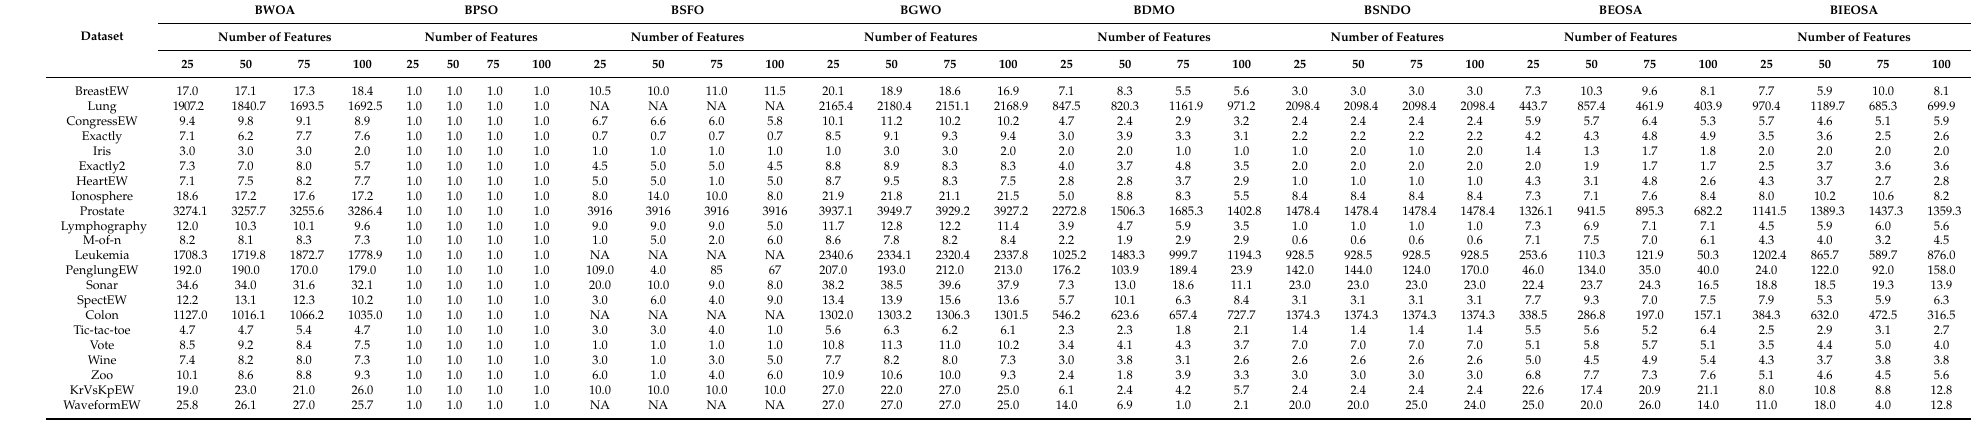
Table 4. Results of the average number of features selected for BWOA, BPSO, BSFO, BGWO, BDMO, BSNDO, BEOSA and BIEOSA on all datasets with population sizes of 25, 50, 75 and